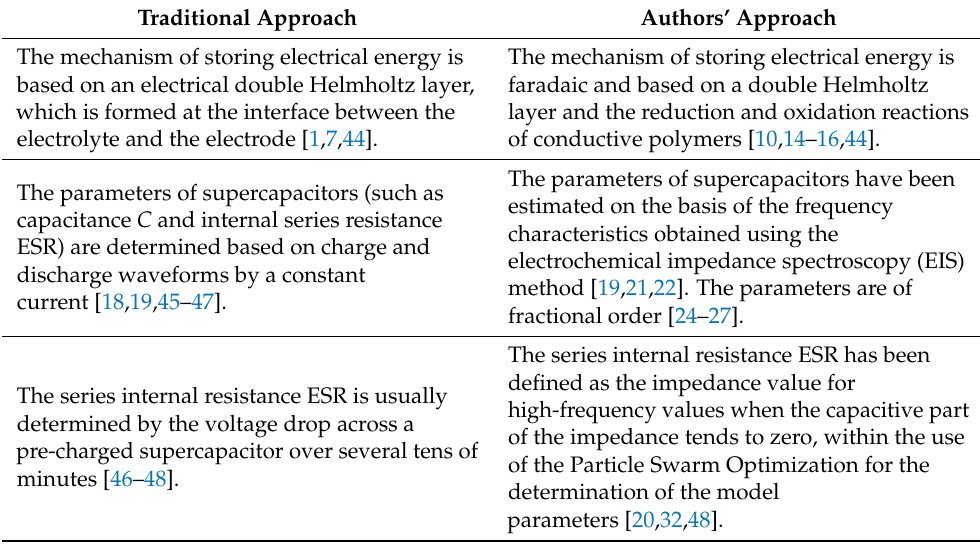
Table 4. Comparison between the state-of-the-art approach and the proposed optimization technique used in the